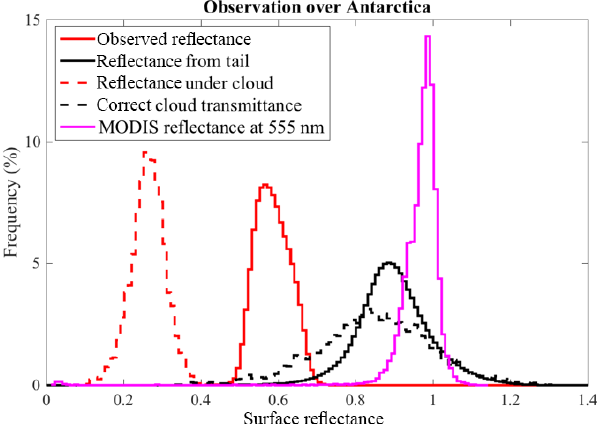
Figure 9. The CALIOP surface bidirectional reflectance distribu- tion at 532nm over Antarctica for clear sky (solid curves) and cloudy sky conditions (dashed curves). The solid red is reflectance computed directly from the saturated signals. The solid black is re- flectance estimated from surface tail with the constant total-to-tail signal ratio of 19.6. The dashed red and black lines are surface re- flectances before and after correcting for cloud two-way transmit- tance. The magenta line shows the MODIS reflectance distribution at